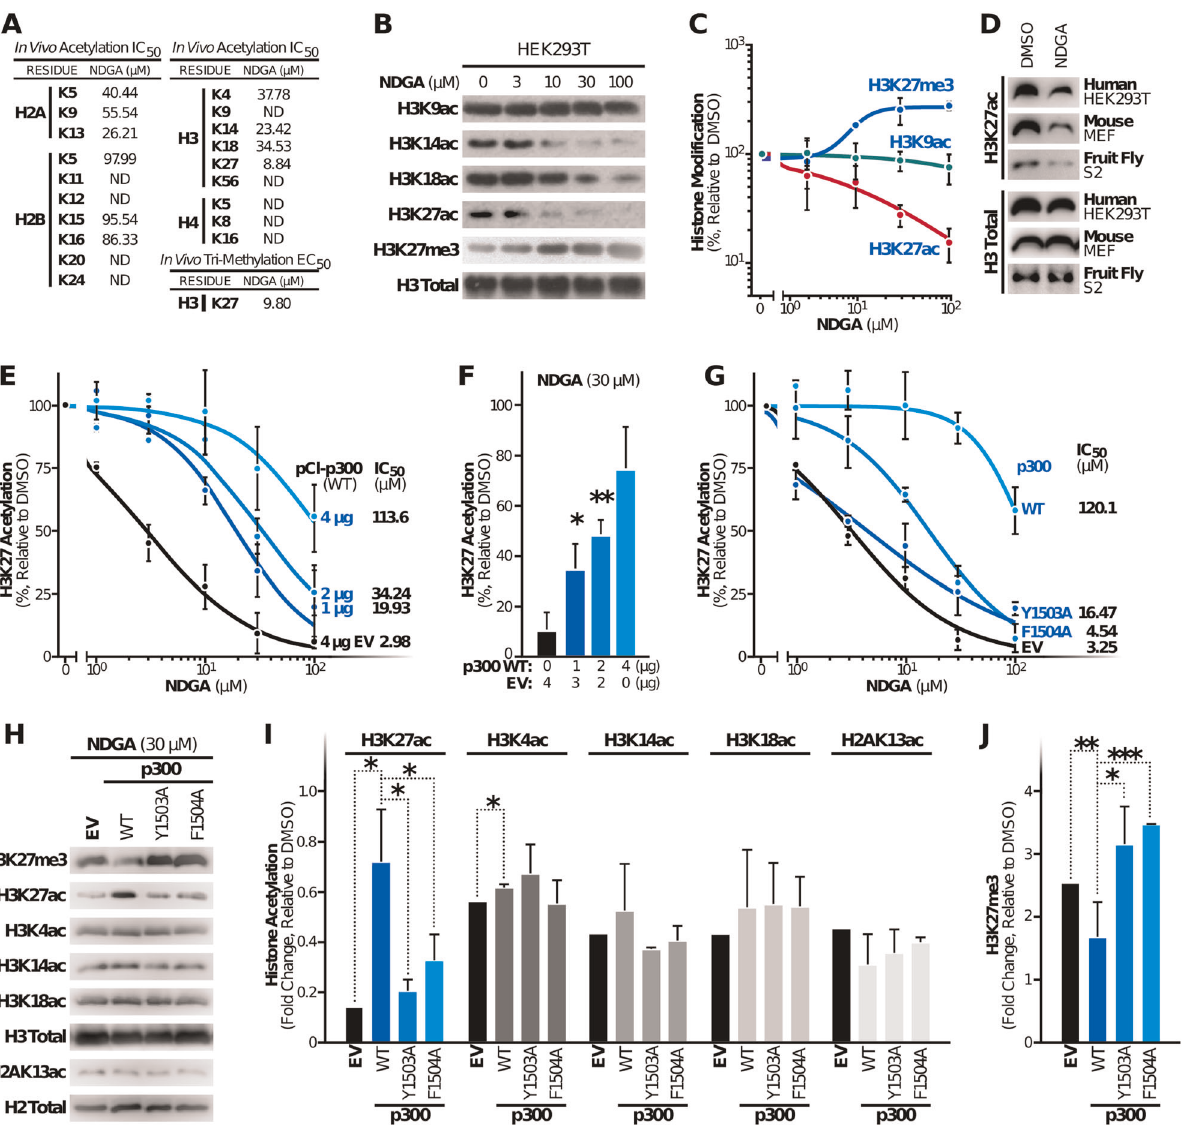
Fig. 2 NDGA inhibits p300-driven histone acetylation in HEK293T cells. a Median inhibitory concentration (IC 50 ) values for NDGA on different acetylated histone residues and median effective concentration (EC 50 ) value on H3K27 tri-methylation were determined by immunoblotting of histones extracted from cells after 24-h treatments with varying concentrations of NDGA (ND, not determined). b Differences in acetylation and tri-methylation of p300 target (H3K14, H3K18, and H3K27) and non-target (H3K9) histones were monitored by immunoblotting after indicated concentrations of NDGA treatment for 24 h and histone extraction. c Dose-dependent changes in acetylation and tri-methylation on H3K27 after 24-h NDGA treatment were analyzed by immunoblotting and are represented as percentage change in histone modi fi cation relative to DMSO treatment. d Decreases in H3K27 acetylation upon 30 µM of NDGA treatment for 24 h in human (HEK293T), mouse (MEF) and fruit fl y (S2 Schneider) cells were monitored by immunoblotting after histone extraction. e . Effects of wildtype p300 overexpression on NDGA- dependent H3K27 hypoacetylation were determined by densitometric analysis of immunoblotting data. Cells were transfected with different amounts of human wildtype EP300 encoding expression plasmid pCI-p300(WT) and/or empty vector (EV) and treated with varying NDGA concentrations for 24 h. The data represent percentage change in H3K27 acetylation relative to DMSO treatment and the change in IC 50 values. f The rescue of p300 overexpression on H3K27 hypoacetylation after 30 µM NDGA treatment was performed as in panel E. g Effects of overexpression of wildtype and catalytically inactive p300 mutants (Y1503A and F1504A) on NDGA-induced H3K27 hypoacetylation were determined by immunoblotting and densitometry. Cells were transfected by the same amount of expression plasmids or empty vector (EV) and treated with varying NDGA concentrations. Histones were extracted and analyzed. h The effects of wildtype and mutant (Y1503A or F1504A) p300 overexpression on NDGA-induced histone hypoacetylation and hypermethylation were determined by immunoblotting after 30 µM NDGA treatment for 24 h. i Effects of wildtype and mutant p300 overexpression on NDGA-induced histone hypoacetylation were analyzed by immunoblotting and densitometry. j Decreased H3K27 tri-methylation upon wildtype p300 overexpression was detected by immunoblotting and densitometry. Total histone antibodies were used as loading controls in all experiments. Data represent the results from two independent experiments (mean ± S.D.) and curves were generated using nonlinear regression fi